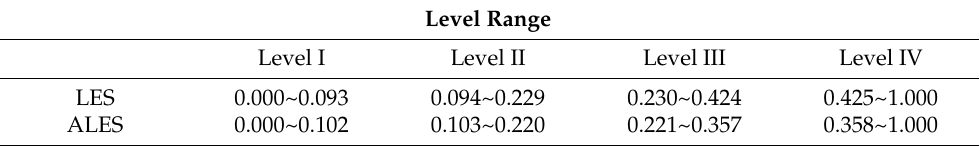
Table 3. LES and ALES value grading